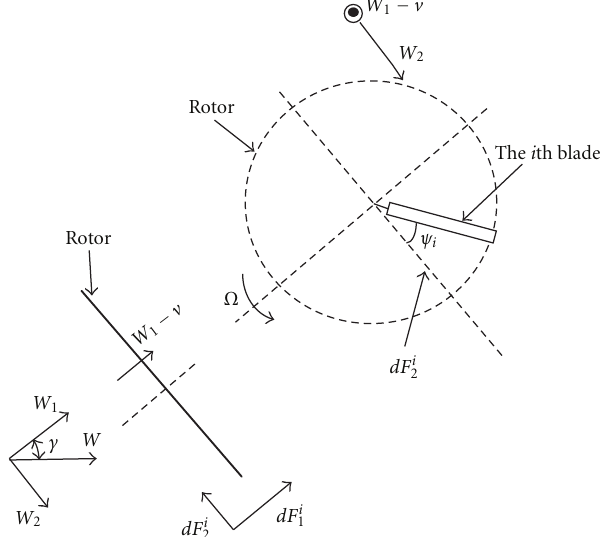
Figure 3: Physical system model in case of yawed wind turbine. W : initial wind speed; W 1 : component of W normal to the plane of rotation; W 2 : component of W parallel to the plane of rotation; v : induced flow; γ : wind direction angle between the wind and the rotor axis; ψ i : angle between W 2 and the i th blade; Ω : angular velocity of rotor; d F i 1 : thrust on the element of the i th blade, which is normal to the plane of rotation; d F i 2 : drag on the element of the i th blade, which is tangential to the circle swept by the i th blade.